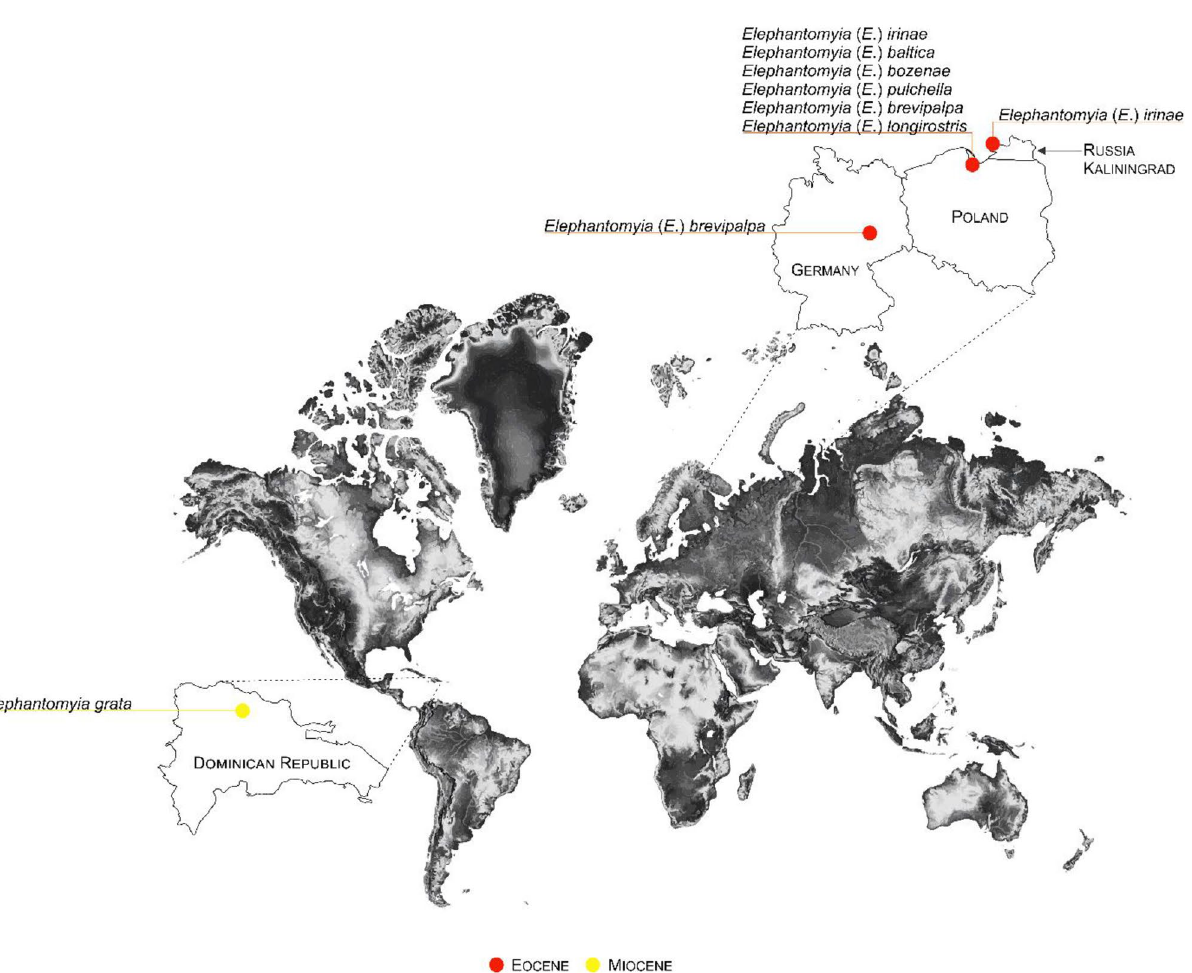
Figure 1. Map with enlarged view of the distribution of know localities of the representatives of the genus Elephantomyia . Map was built using the map Maps-For-Free (https:// maps- for- free. com) and modified with the software programs Corel Draw and Corel Photopaint